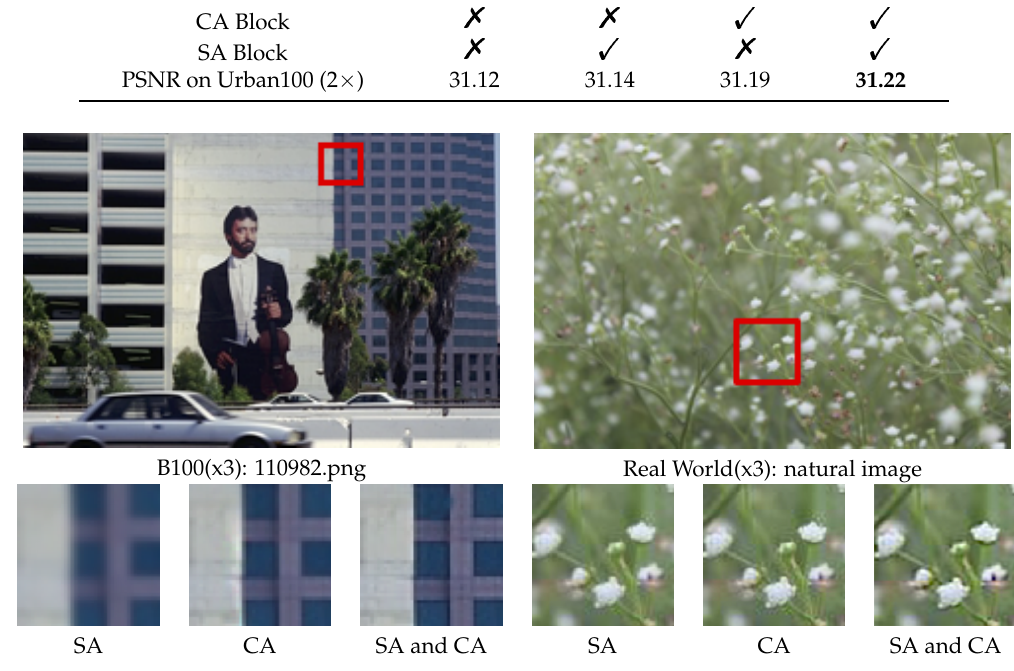
Figure 7. SR results ( × 3) of different